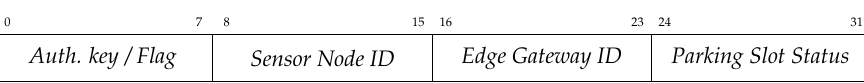
Figure 7. Edge gateway to LoRa gateway data transmission packet payload format.